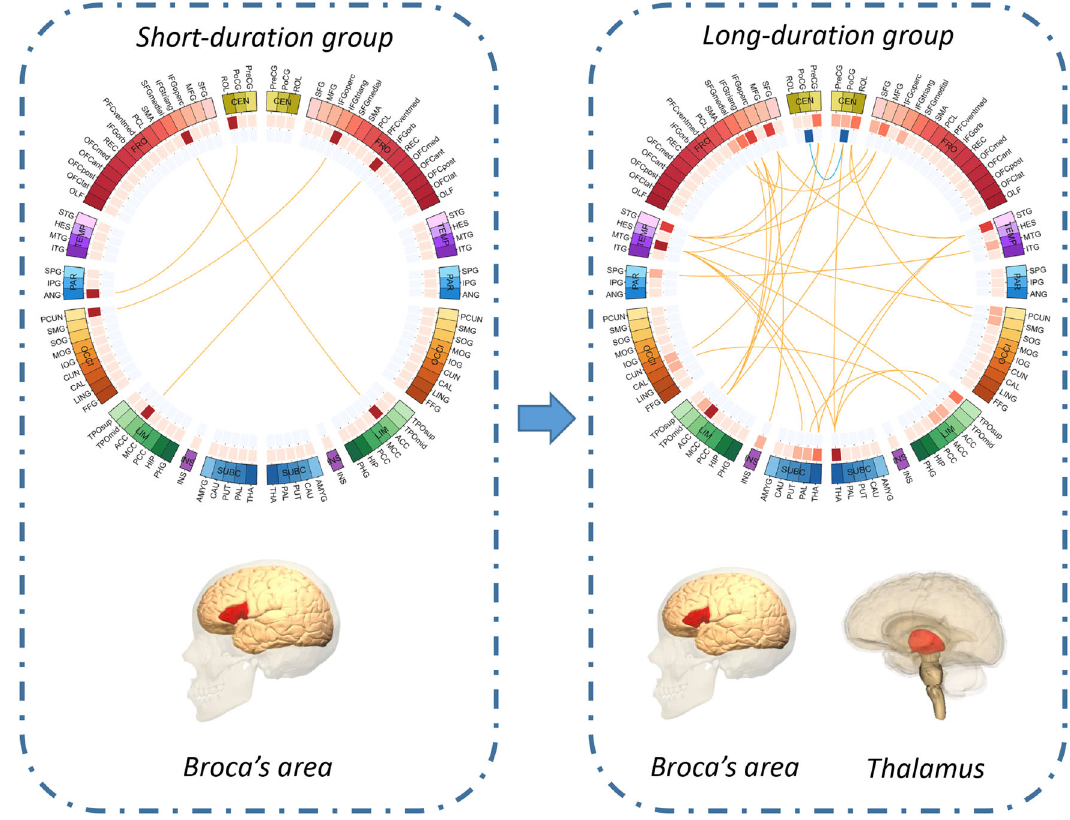
Fig. 2 Signi fi cantly altered functional connectivity clusters (FC clusters) identi fi ed in both the short-duration group (11.2 ± 6.2 weeks) and the long-duration group (48.6 ± 22.8 weeks) fi rst-episode schizophrenia (FES) patients. The color of the 3 circles (from inside to outside) denotes: the number of deceased functional connectivity; the number of increased functional connectivity; the 94 brain regions in automatic anatomical labeling (AAL2) atlas. Red lines mean that FES patients have a higher mean functional connectivity than healthy controls, and blue lines indicate the opposite. The anatomical abbreviations in the fi gure are shown in the Supplementary Table 1. Short- duration group had functional dysconnectivity mainly in the Broca ’ s area (the left inferior frontal gyrus), while long-duration group had widespread functional dysconnectivity involving both the left inferior frontal gyrus and the thalamus. The brain images in this fi gure are snapshots of 3D brain model of the Society for Neuroscience (2017) retrieved from https://www.brainfacts.org/3DBrain.